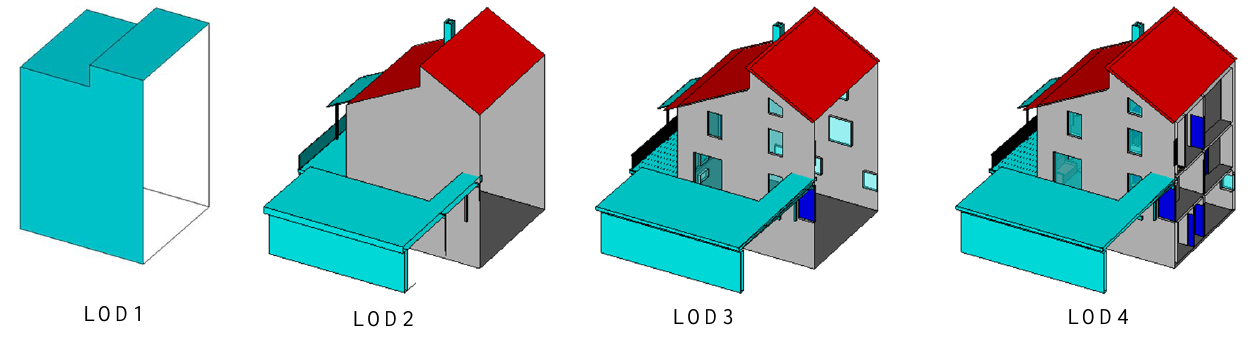
Figure 1. Building model representation for LOD1 to LOD4 according to CityGML (taken from